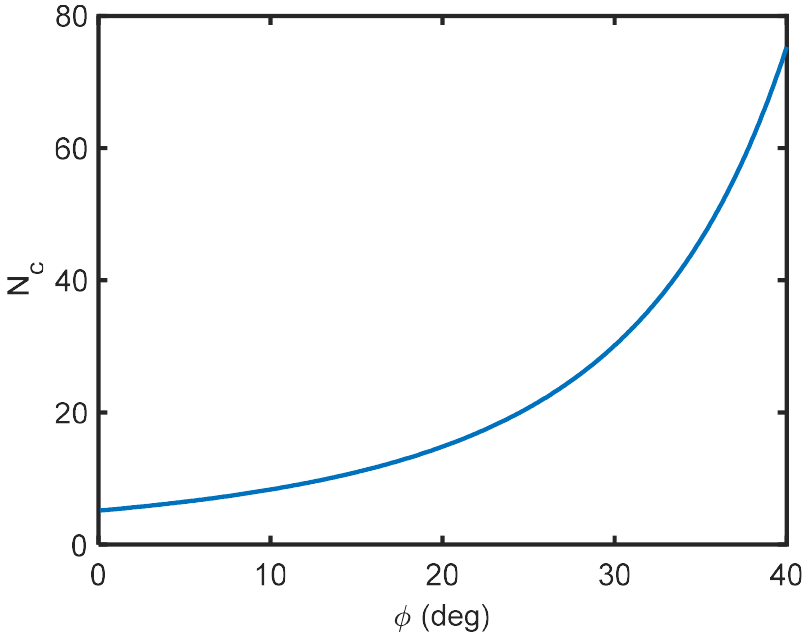
Figure 3. Bearing capacity factor N c as a function of internal friction angle ϕ , from [25] .